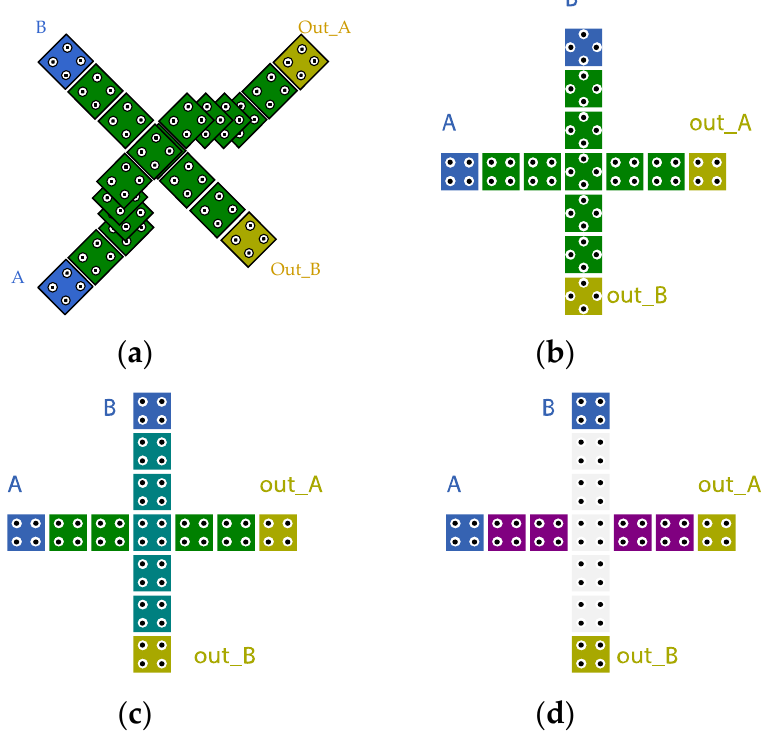
Figure 3. Crosswires. ( a ) Multilayer crosswire, ( b ) coplanar crosswire implemented by rotating QCA cells in [31], ( c ) coplanar crosswire implemented by QCA cells in clock zones 1 and 3 in [32], and ( d ) coplanar crosswire implemented by QCA cells in clock zones 2 and 4 in [32].